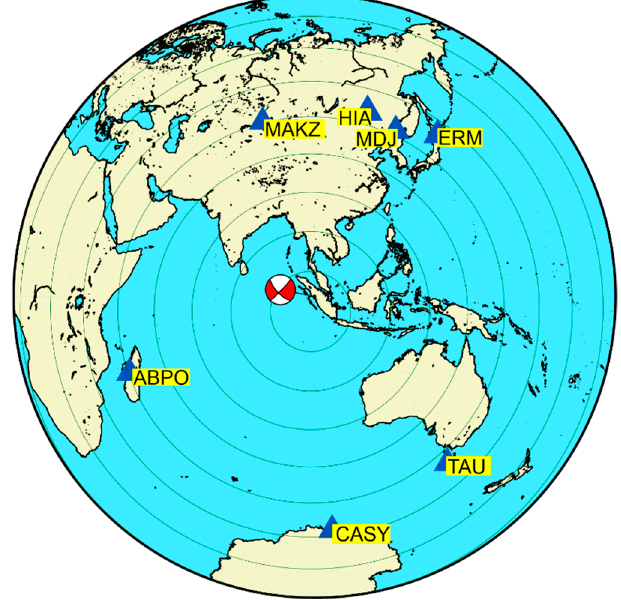
Figure 6. The selected station was used in the inversion. The green circle represents epicenter distances between 30° and 90° from the Mw 6.1 Pasaman earthquake. The red-white beach ball shows the earthquake location and the fault type as the earthquake souce.